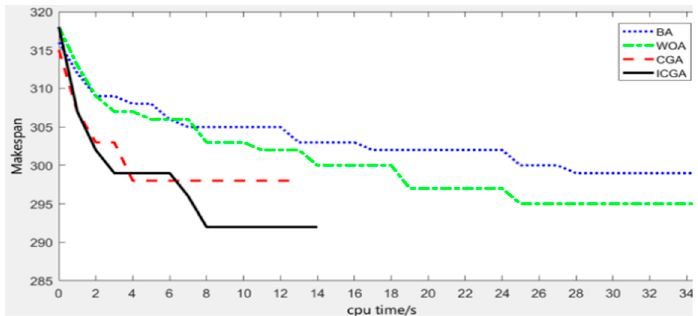
Figure 5. Relationship between fitness value and training iterations of schemes 5–8. Figure 6. Relationship between fitness value and Running time of schemes 5–8.